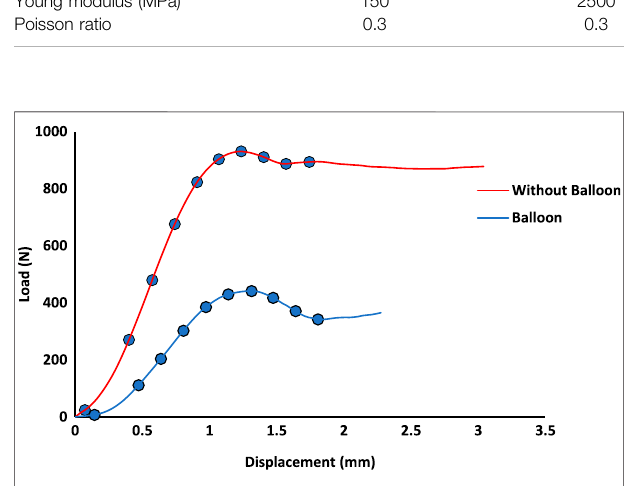
FIGURE 3 | Load – displacement curve for a sample with a 1 mm/min loading condition, with and without a balloon. The circles on the curve represent the loading steps that were chosen to analyze using H-DIC.